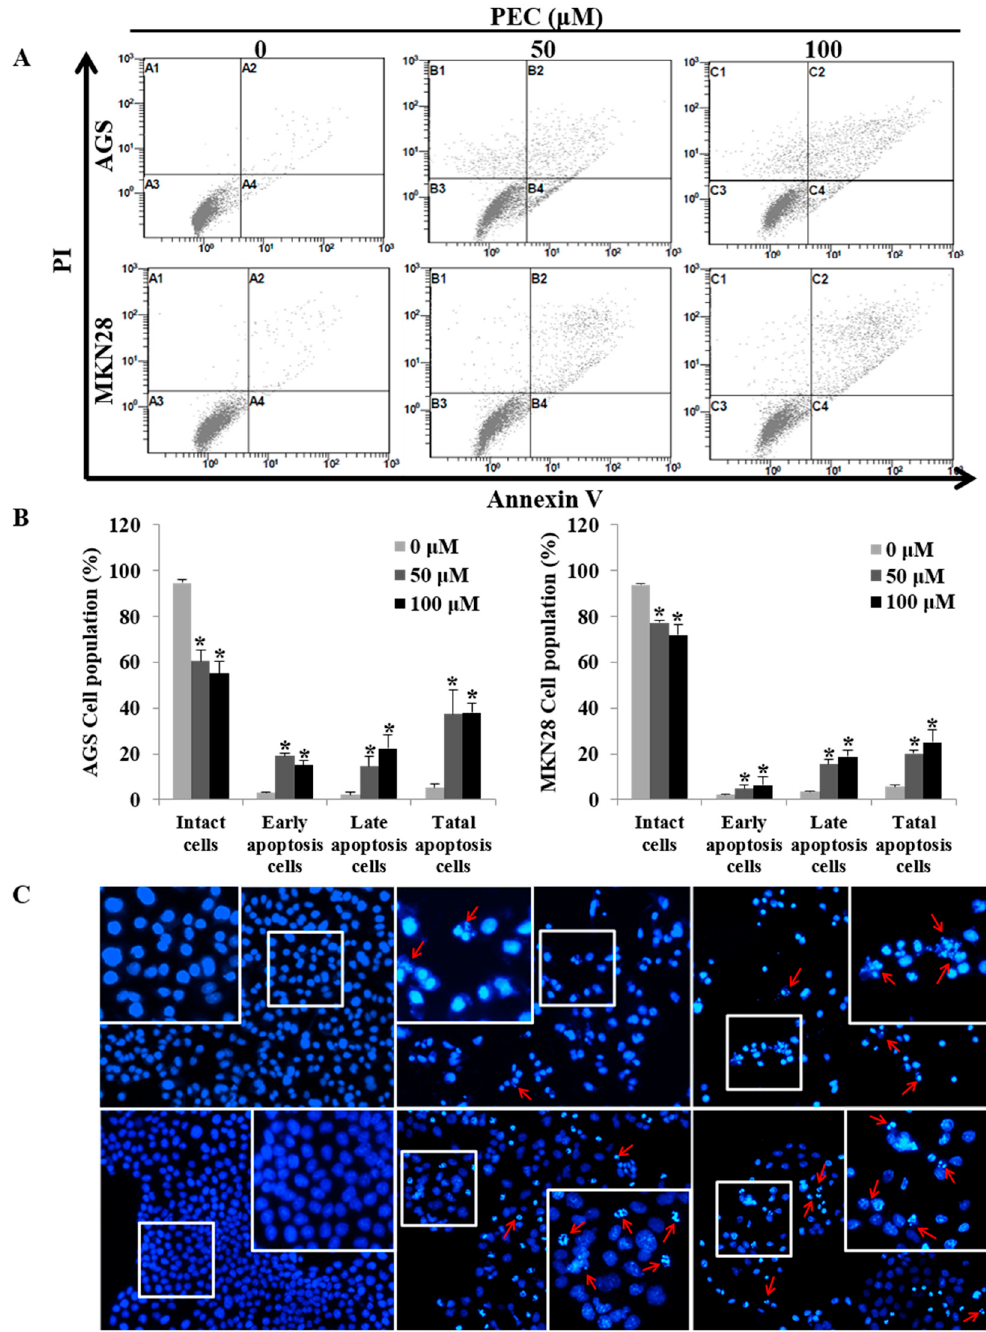
Figure 3. PEC induces dose-dependent apoptosis in AGS and MKN28 cells. ( A , B ) Cells were treated with indicated concentrations of PEC for 24 h. Apoptotic cells were stained with Annexin V/PI kit and determined by flow cytometry. The cells were analyzed using CXP Software. Results are expressed as the mean ± standard deviation (SD) of at least three independent experiments. Statistical differences were analyzed with Student’s t -test (* p < 0.05 vs. control). ( C ) Both AGS and MKN28 cells were stained with Hoechst 33342 and examined under fluorescence microscopy (×400). (Red arrows showing bright blue regions indicate fragmented or condensed nuclei.)